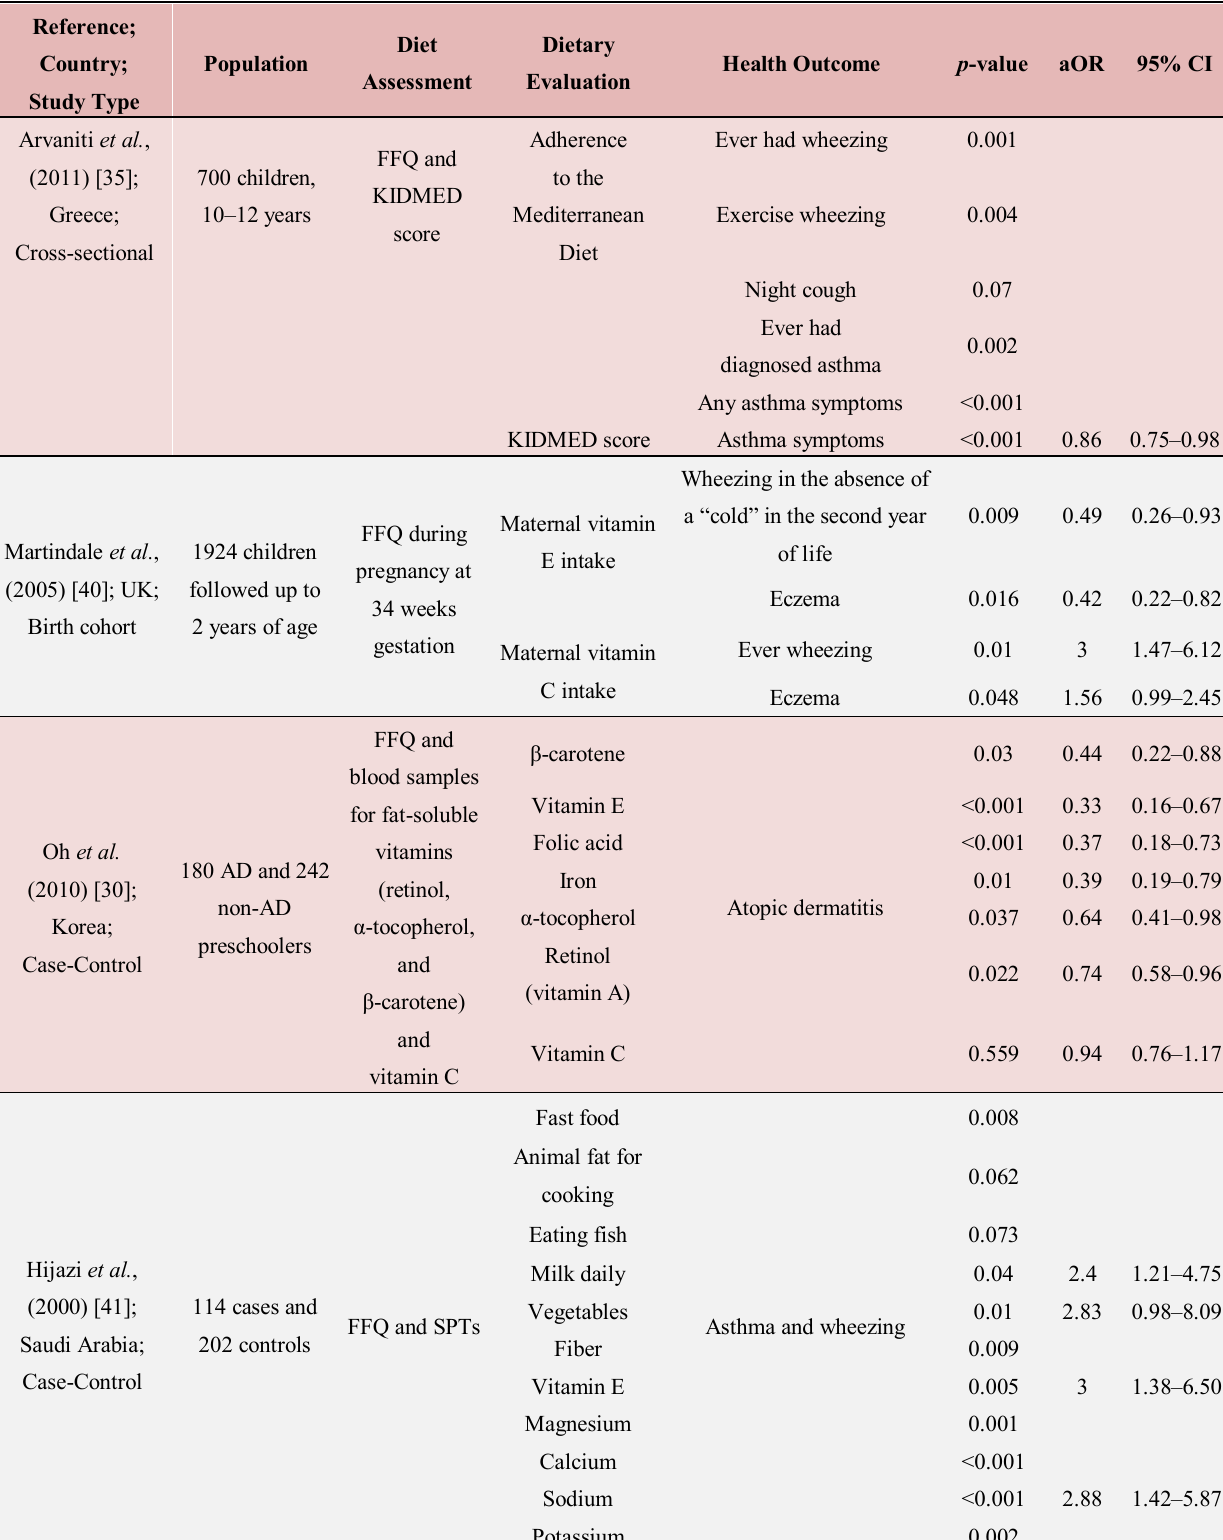
Table 1. Results and association between diet and allergic diseases in children in recent international epidemiological